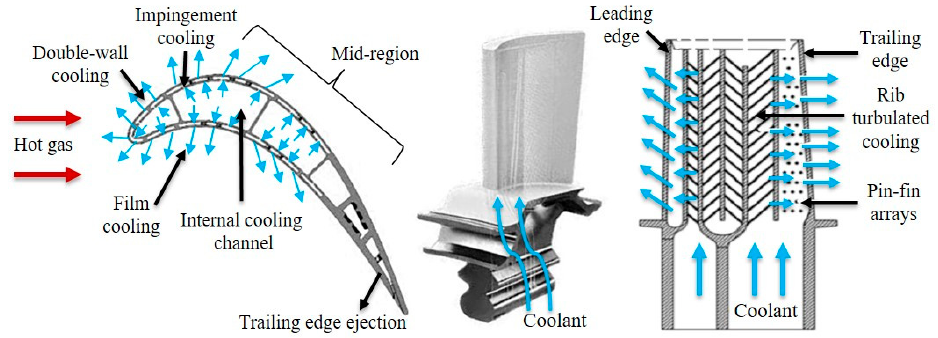
Figure 2. Schematic of cooling technology in gas turbines.